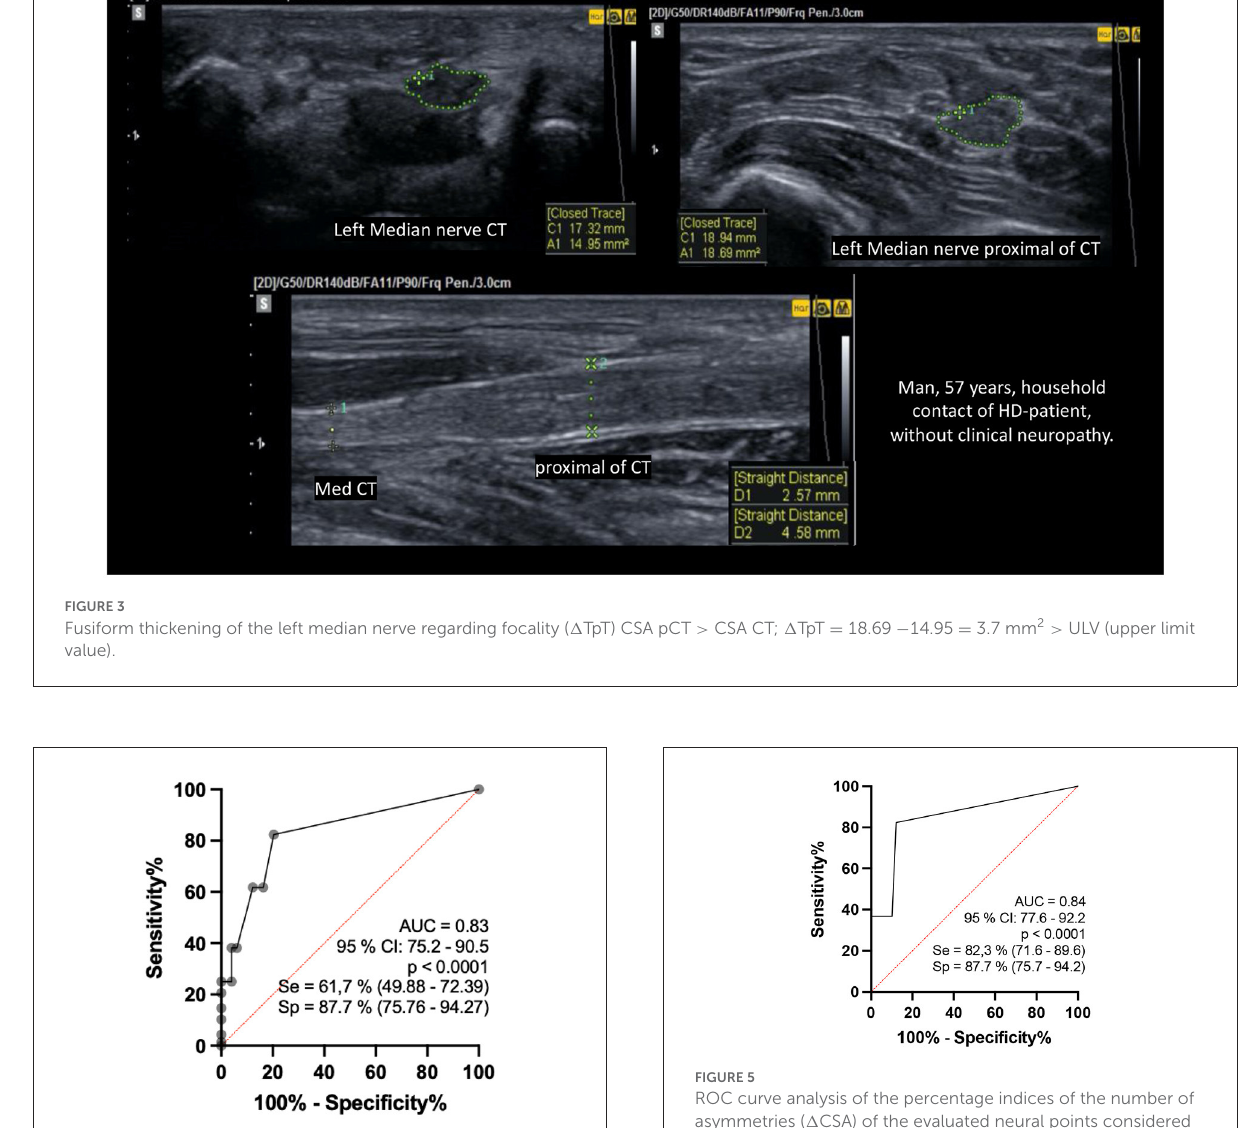
FIGURE5 ROC curve analysis of the percentage indices of the number of asymmetries ( 1 CSA) of the evaluated neural points considered to be altered per individual when comparing the groups of healthy persons and contacts of patients with HD (b – on the right).